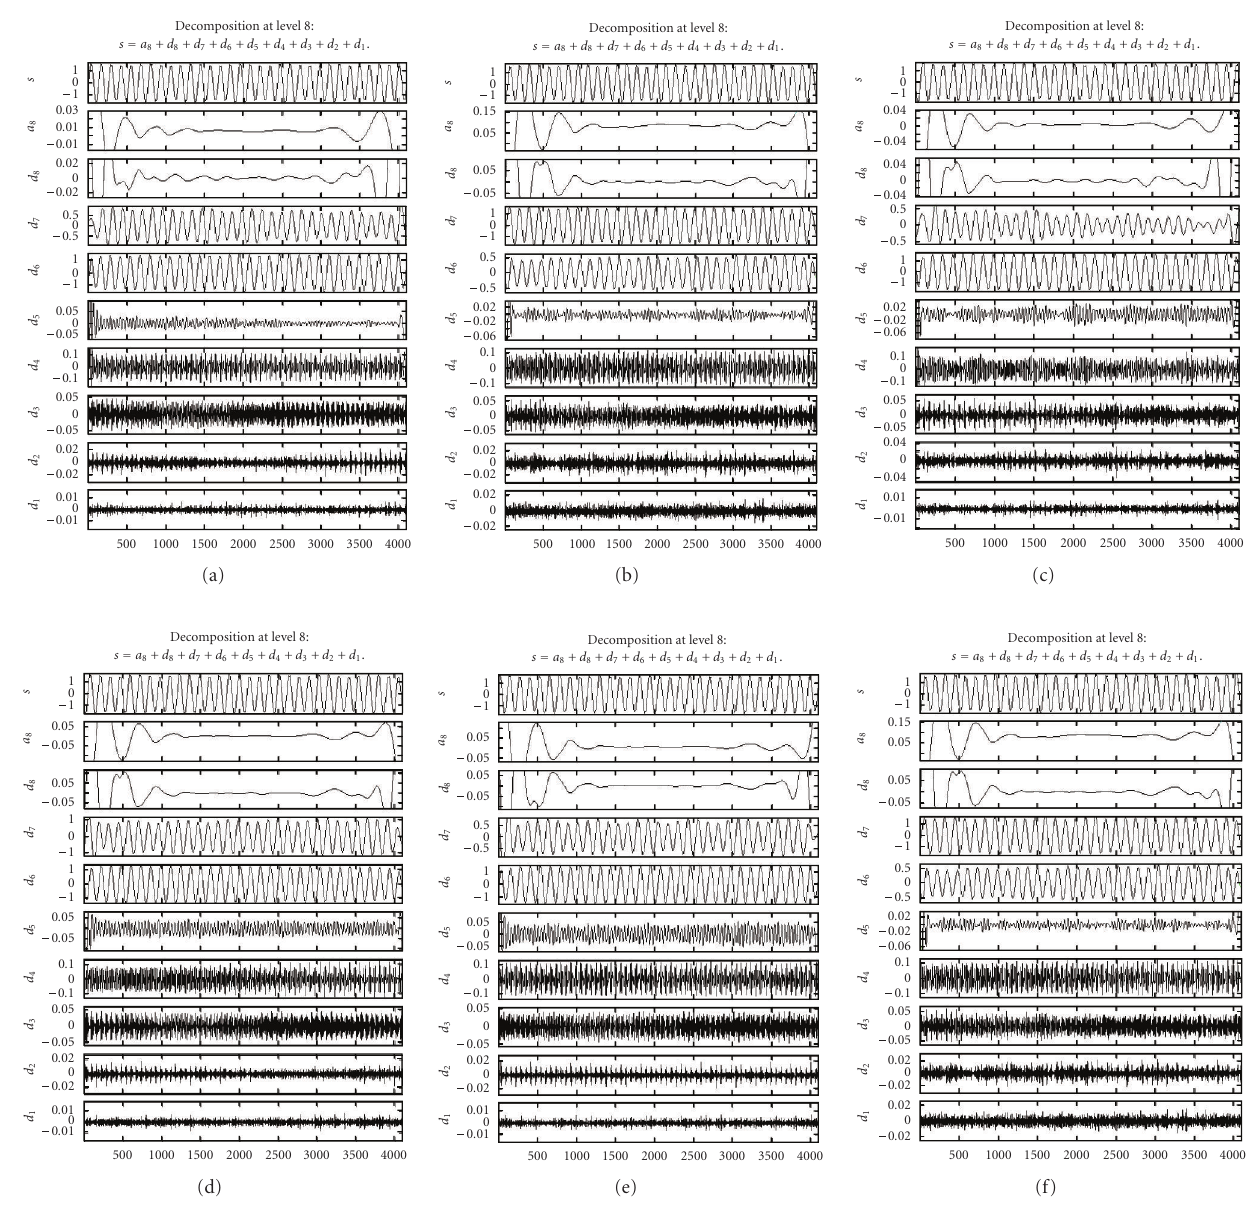
Figure 8: Details of motor stator current signals under full-load condition. (a) Normal condition, (b) bowed rotor, (c) broken rotor bar, (d) faulty bearing (outer race), (e) rotor unbalance, (f) misalignment.